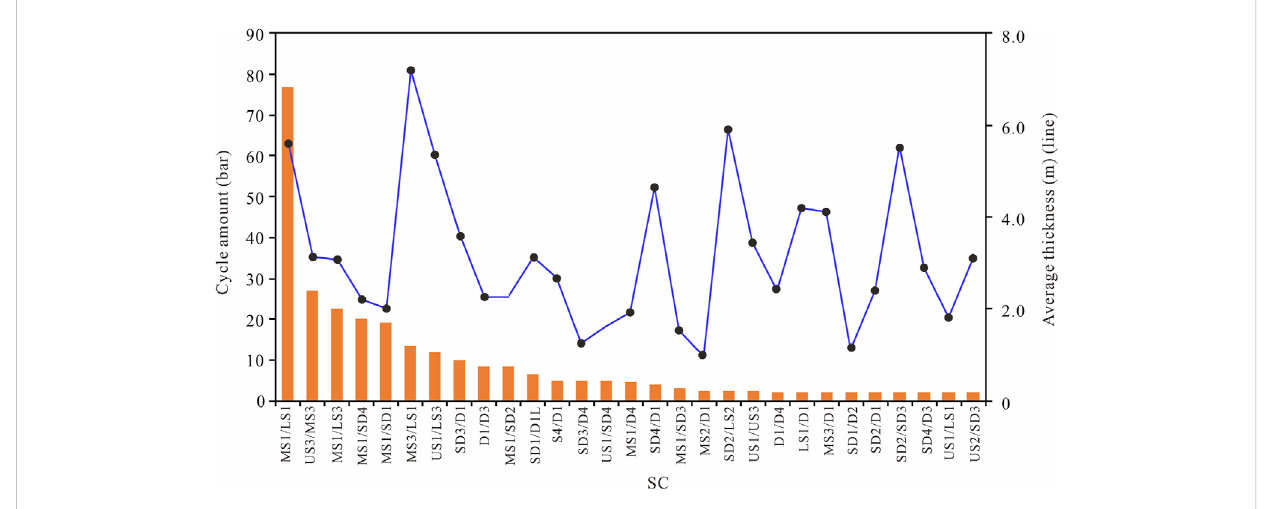
FIGURE 4 Amount and average thickness of SCs in Es 4 u of Well